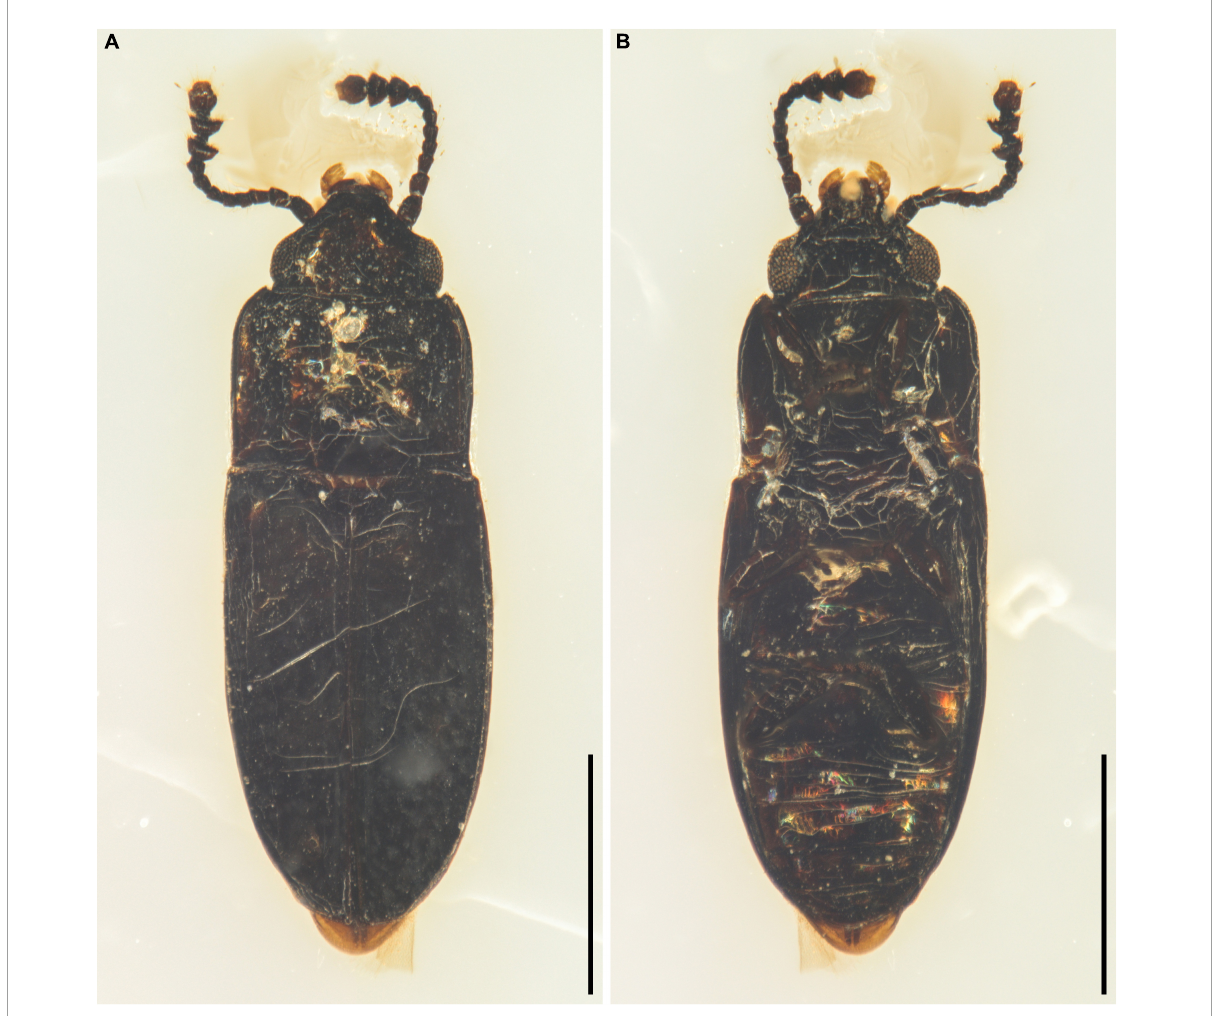
FIGURE1 General habitus of Alloterocucus atratus Li, Leschen Liu, and Cai gen. et sp. nov., holotype, NIGP180056, under incident light. (A) Dorsal view. (B) Ventral view. Scale bars: 500 µ